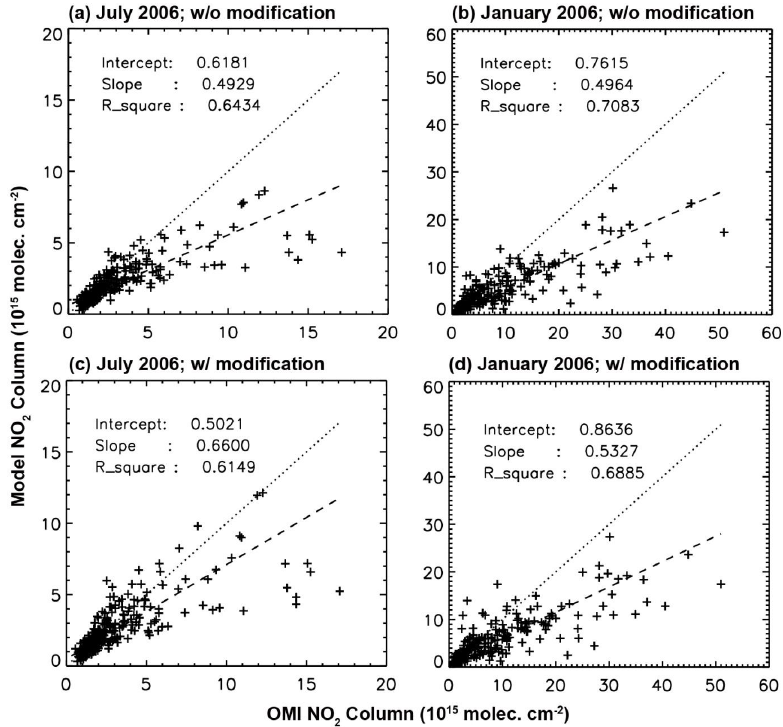
Fig. 2. Scatter plot for NO 2 columns at the 284 meteorological stations in East China retrieved from OMI and simulated by GEOS-Chem with and without post-model modifications discussed in Sect. 6. Also presented is the statistics from the RMA